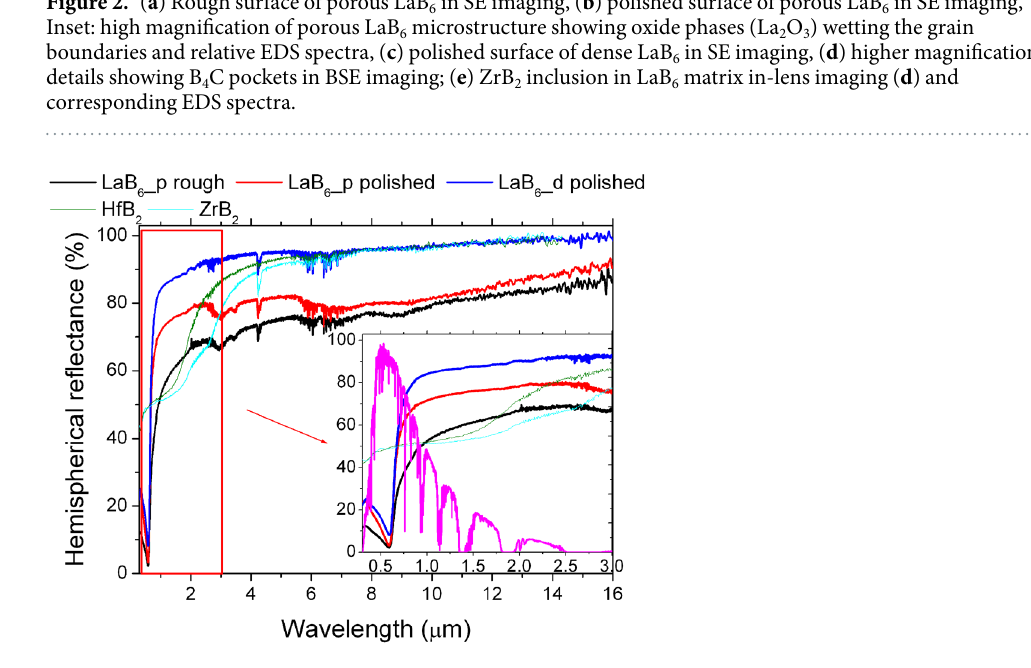
Figure 3. Reflectance spectra of samples, compared to dense samples of hafnium and zirconium borides from ref.